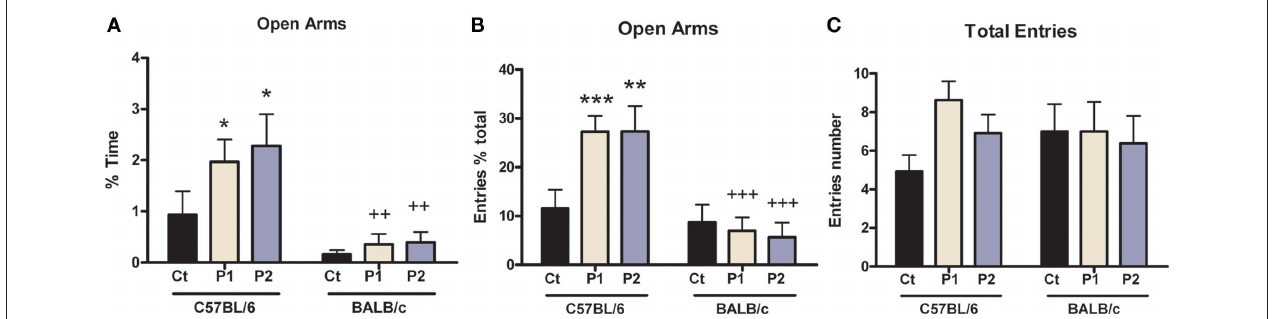
arms exploration than their respective MS BALB/c mice. n = 11–19 per strain per stress condition. Data expressed as means ± SEM. Black “Ct,” control AFR groups; white “P1,” protocol 1; blue “P2,” protocol 2. * p < 0.05, ** p < 0.01, *** p < 0.001 stress vs. control groups; + p < 0.05, ++ p < 0.01, +++ p < 0.001, C57BL/6 vs. BALB/c